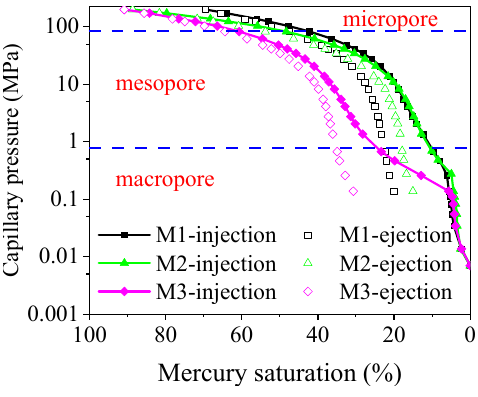
Figure 1. Capillary pressure